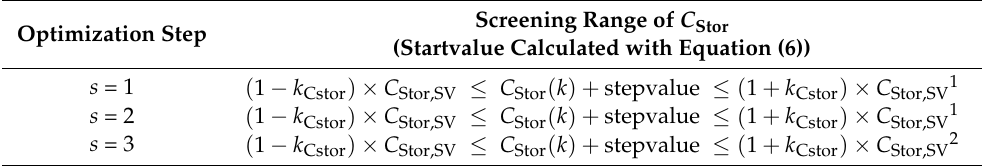
Table 6. Formulation of screening ranges of C Stor